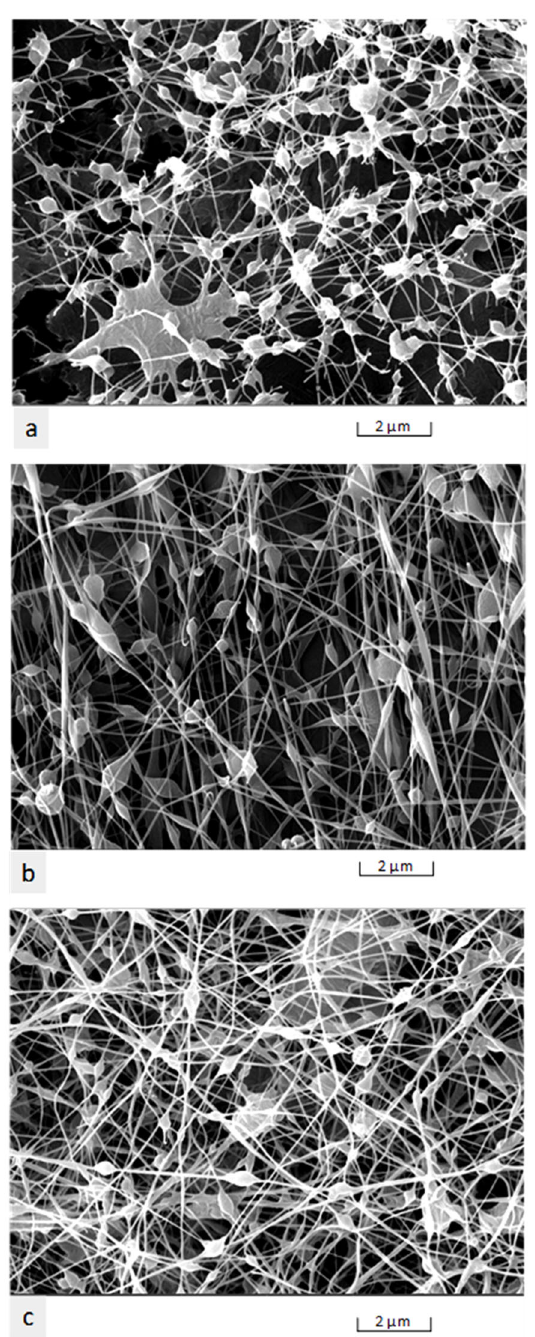
Figure 7. SEM micrographs—the influence of voltage on fibre morphology: ( a ) 22 kV; ( b ) 26 kV; and ( c ) 30 kV.